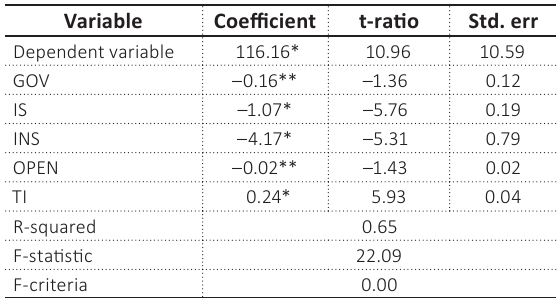
Table 5. Panel data (time series cross-section)